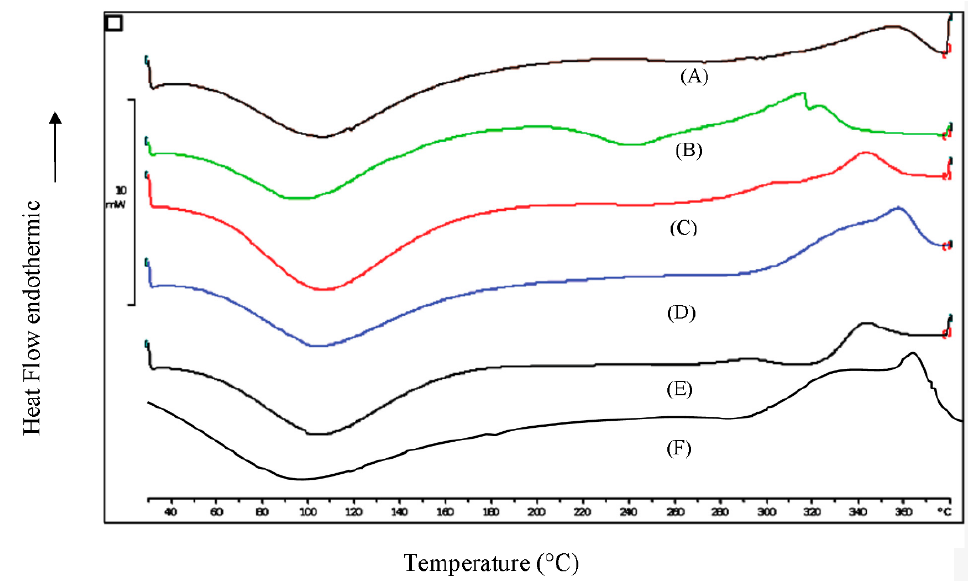
Figure 3. DSC thermogram of cellulose A (preparation 1) ( A ); cellulose B (preparation 2) ( B ); cellulose C (preparation 3) ( C ); cellulose D (preparation 4) ( D ); cellulose E (preparation 5) ( E ); and CMSC ( F ).